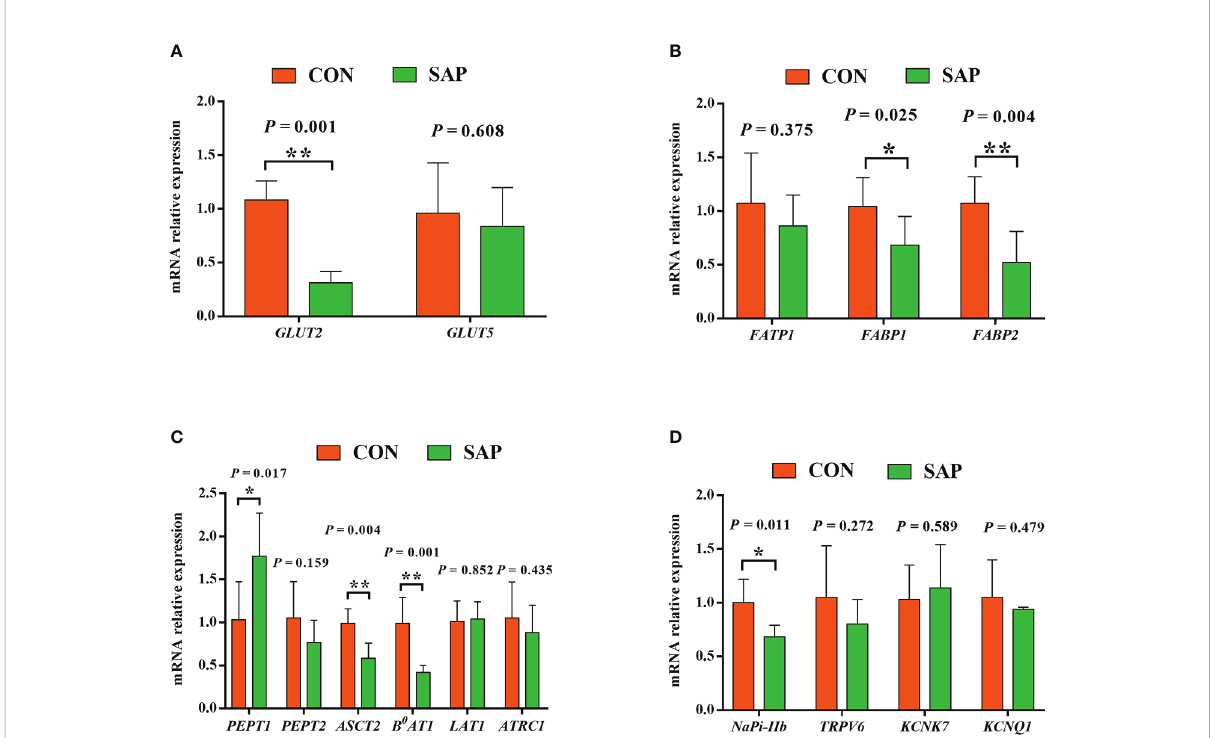
FIGURE 4 Effect of dietary soybean saponin Bb mRNA relative expression of small intestinal nutrient transporter genes (A – C) and ion transporters/channel genes (D) ( n = 6). * p < 0.05; ** p < 0.01; Student ’ s t -test. GLUT2 , glucose transporter 2; GLUT5 , glucose transporter 5; FATP1 , fatty acid transporter 1; FABP1 , fatty acid binding protein 1; FABP2 , fatty acid binding protein 2; PEPT1 , polypeptide transporter 1; PEPT2 , polypeptide transporter 2; ASCT2 , amino acid transporter 2; B 0 AT1 , B 0,+ -type amino acid transporter 1; ATRC1 , cationic amino acid transporter 1; LAT1 , large neutral amino acid transporter 1; Napi-IIb , sodium-dependent phosphate transport protein 2b; TRPV6 , transient receptor potential cation channel subfamily V member 6; KCNK7 , potassium two pore domain channel subfamily K member 7; KCNQ1 , potassium voltage-gated channel subfamily Q member